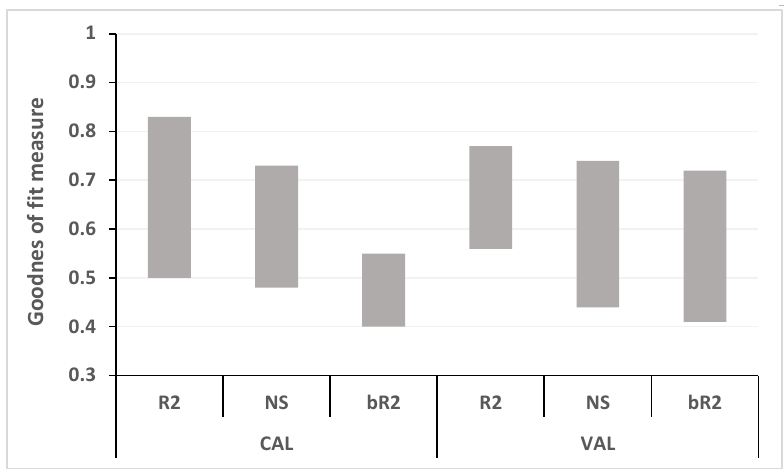
Figure 5. Ranges of goodness of fit measures R 2 , NSE, b R 2 , for the outlet stations of the six sub-basins for the calibration and validation periods.